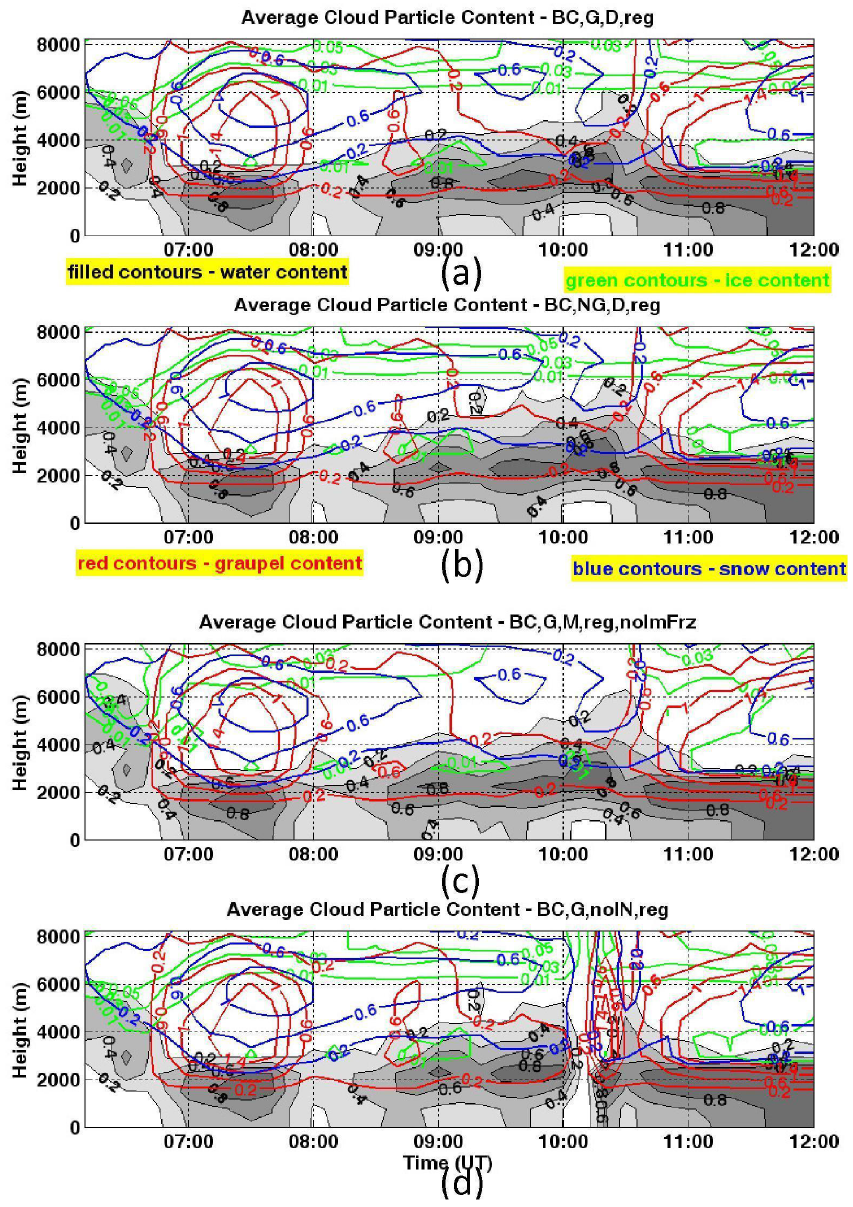
Fig. 10. Average cloud particles’ mixing ratios as function of time and height in the area which is marked by a red rectangle in Fig. 4.